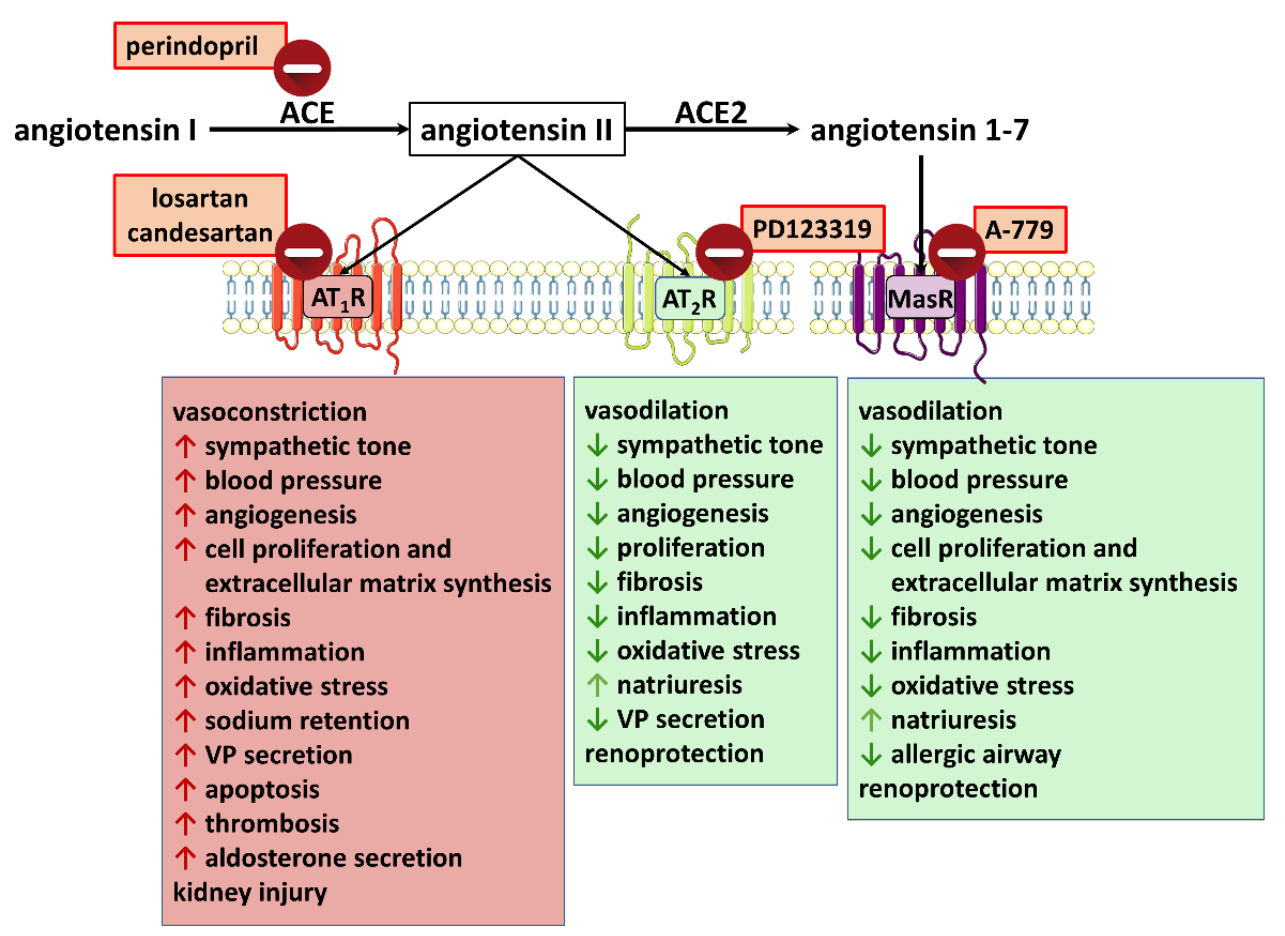
Figure 3. Simplified diagram of the renin-angiotensin system (RAS) and modifying drugs mentioned in this review. The RAS consists of two axes that counteract each other: A deleterious one (so-called classic; red rectangle) containing angiotensin-converting enzyme (ACE)/angiotensin II (Ang II)/Ang II type 1 receptors (AT 1 Rs) and a protective one (so-called alternative; green rectangles) constituted by (i) Ang II type 2 receptors (AT 2 Rs) and (ii) angiotensin-converting enzyme type 2 (ACE2)/angiotensin 1-7) and its Mas receptors (MasR). VP, vasopressin. Red circles with minus signs describe antagonism, inverse agonism, or inhibition at the respective mechanism. Up arrows, increase; down arrows, decrease; green arrows, desired effects; red arrows, undesired effects.